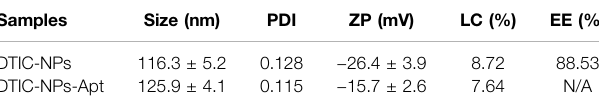
TABLE 1 | Characterization of DTIC-NPs and DTIC-NPs-Apt (Mean ± SD, n = 3).